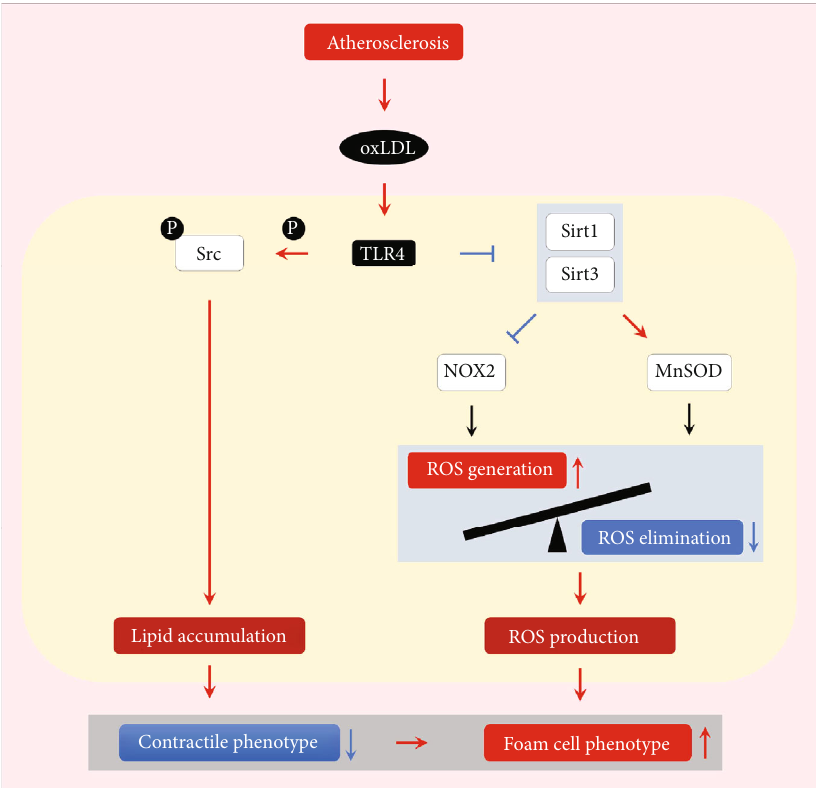
Figure 7: Overall network of Tlr4 in regulating oxLDL-induced foam cell formation in